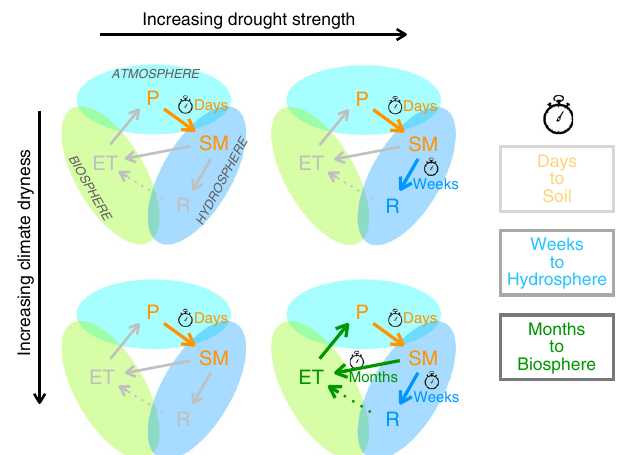
Fig. 5 When and where drought jumps geospheres. Propagation of drought- inducing precipitation (P) de fi cits to soil moisture change (SM), through the whole catchment hydrosphere to blue-water runoff (R), and to the biosphere through green-water evapotranspiration (ET) back into atmosphere. Weaker droughts only affect soil moisture change, while the impacts of stronger droughts propagate through the entire hydrosphere to R in all climates, and to ET and the biosphere in dry climate. This summary is valid across the investigated European climate regimes and